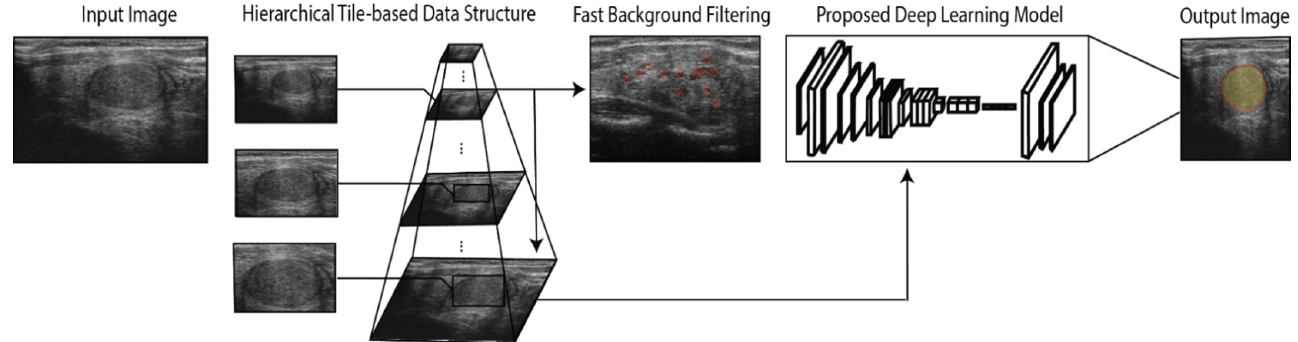
Figure 1. Schematic block diagram of the proposed methodology.